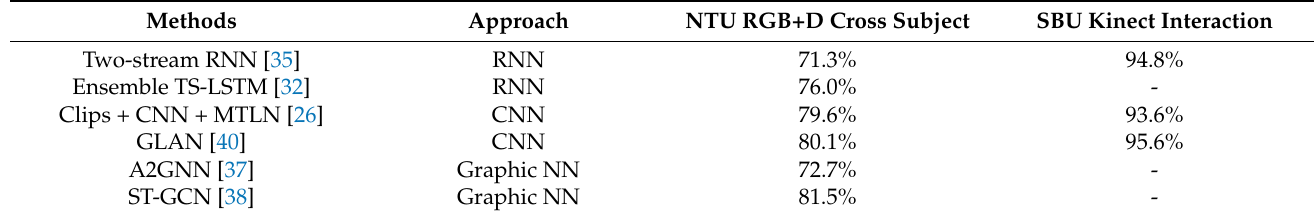
Table 1. Performance of skeleton-based action recognition models in the